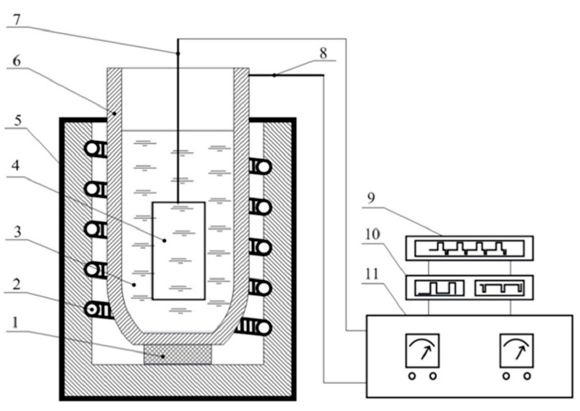
Figure 1. Schematic of experimental setup: 1—ceramic stand; 2—heating element; 3—molten